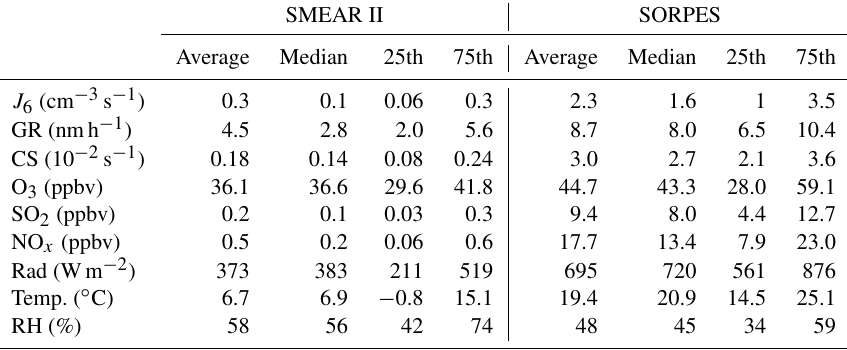
Table 1. Statistics of observed formation rates of 6nm particles ( J 6 ) , growth rates of 6–30nm particles (GR), condensation sinks (CS), O 3 , SO 2 and NO x concentrations, radiation (Rad.), air temperature (Temp.), and relative humidity (RH) from 09:00 to 15:00LT on NPF days at SMEAR II and SORPES. Note the statistical samples are the whole-year database of 2013 at SMEAR II and the whole-year database of 2014 at SORPES.